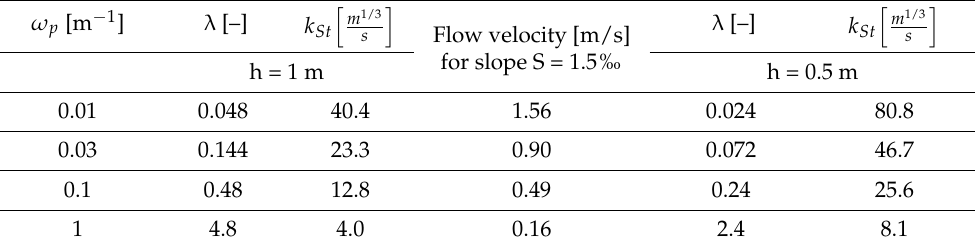
Table 1. Value ranges of the vegetation parameter when recomputed to skin friction parameters for two different flow